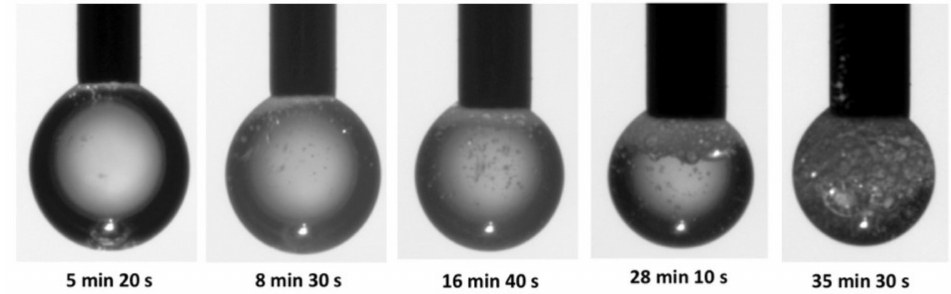
Figure 2. Foam generation in aqueous Vancomycin droplets (V d = 5 µ L) during the second harmonic ( λ = 532 nm) of Nd:YAG fundamental laser